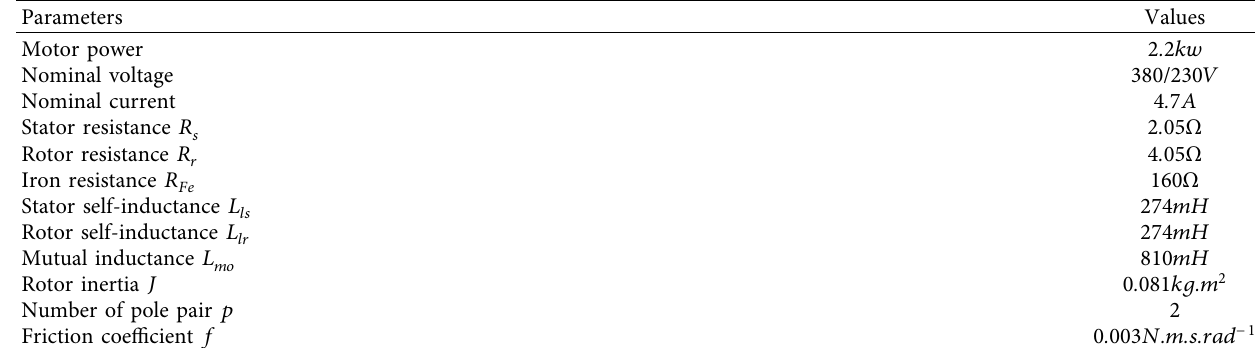
Table 1: Parameters of induction motor model.